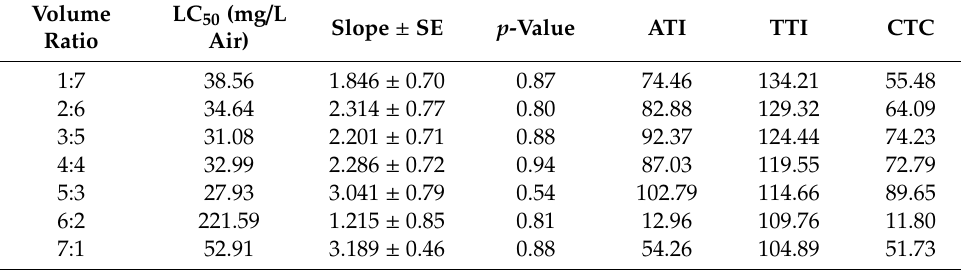
Table 7. Fumigant toxicity and CTC of carvone and limonene mixture against larvae of T. castaneum